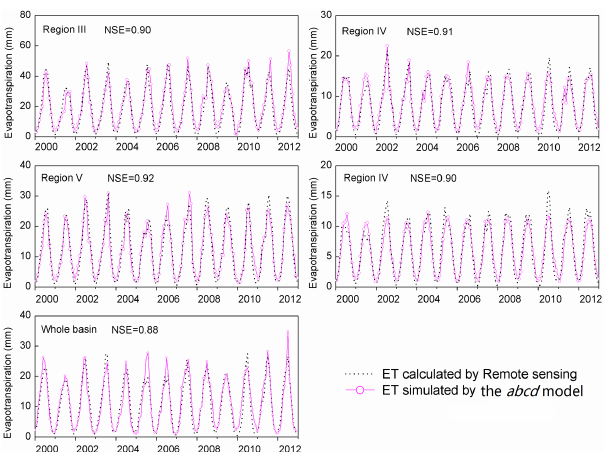
Figure 5. Comparison between ET simulated by the abcd model and ET calculated by remote sensing data for regions III–VI and the whole basin during 2000–2012. “WBM” denotes the abcd water balance